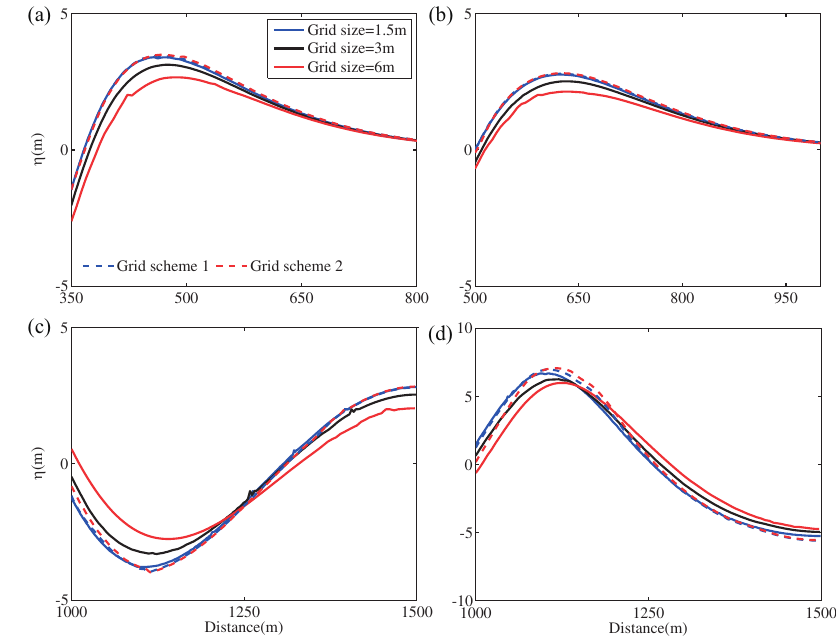
Figure 8. Computational results of different mesh schemes compared with that of original global uniform mesh calculation: ( a ) t = 15 s; ( b ) t = 20 s; ( c ) t = 50 s; and ( d ) t = 60